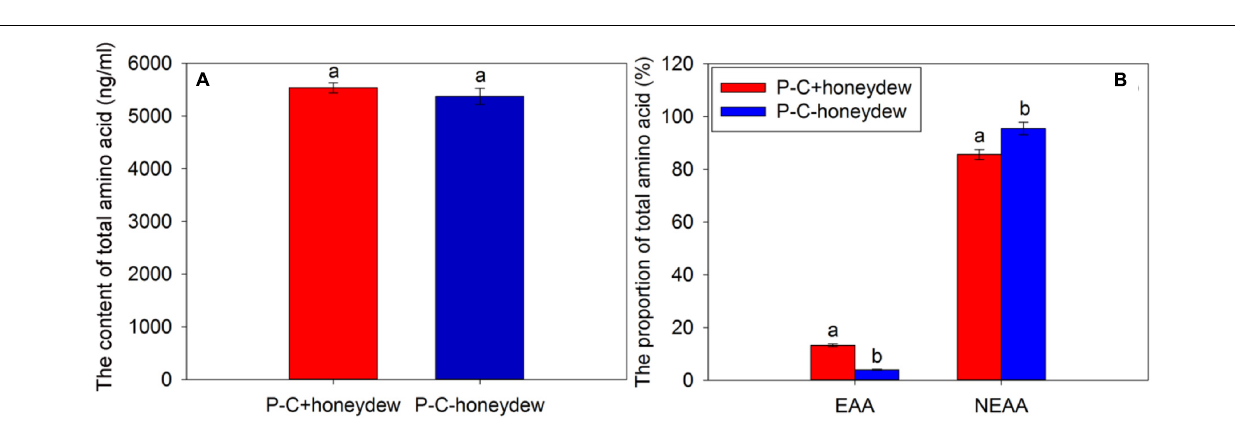
FIGURE 5 | The contents of total amino acids (A) and the proportions of EAAs and NEAAs (B) in honeydew excreted by ACP nymphs feeding on C Las-infected and C Las-free citrus plants. “P+” and “P–” represent C Las positive and negative psyllids, respectively, and “C+” and “C–” represent C Las-infected and C Las-free citrus plants, respectively. Values are represented as mean ± SE, and different letters over the bars mean significant differences between groups at P <